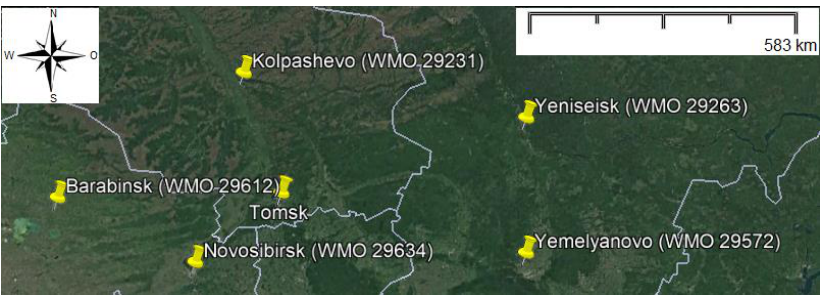
Figure 8. Location map of aerological stations closest to Tomsk according to the website [37]; the image was obtained with the geographic information system Google Earth Distribution of HLC specular area sizes (2016–2020). Table 4. Aerological stations located within a radius of 500 km from Tomsk. Station Location Station